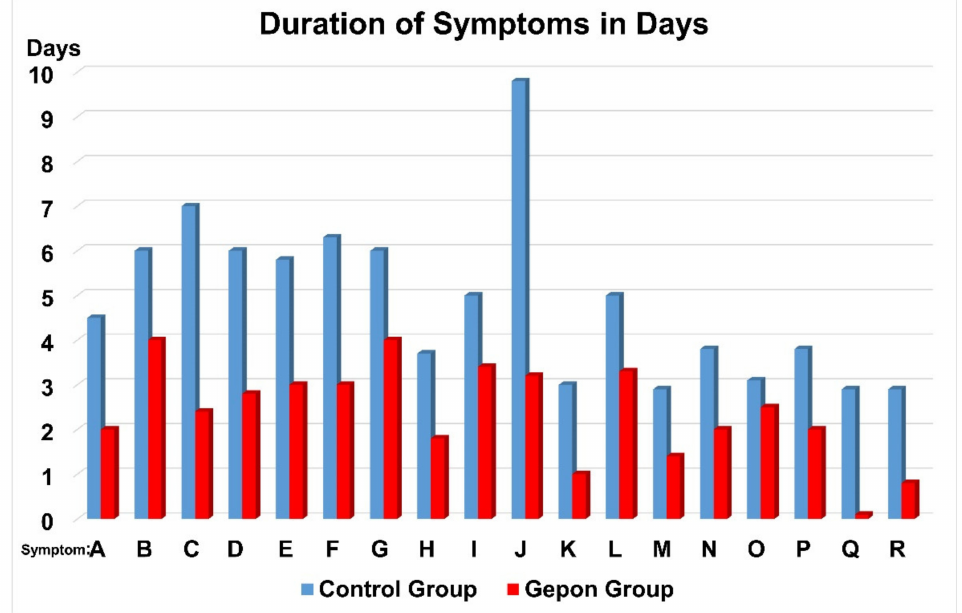
Figure 4. Duration of clinical symptoms (days). Control Group n = 50 (blue) Gepon group n = 50 (red). Horizontal divisions in days. Symptoms: A—Fever, B—difficulty in breathing, C—serous rhinitis, D—swelling of nasal mucous membrane, E—hyperaemia of tissues, F—pharyngitis, G—swollen